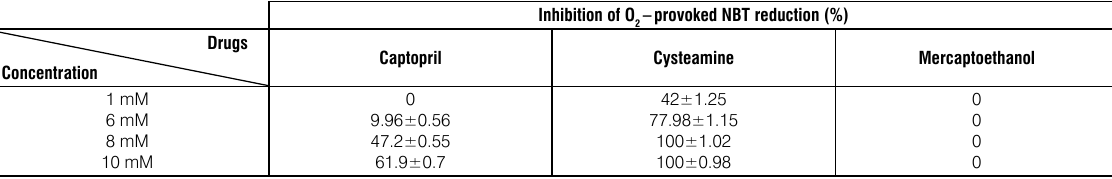
Table 1. Effects of capropril, cysteamine and mercaptoethanol on the O